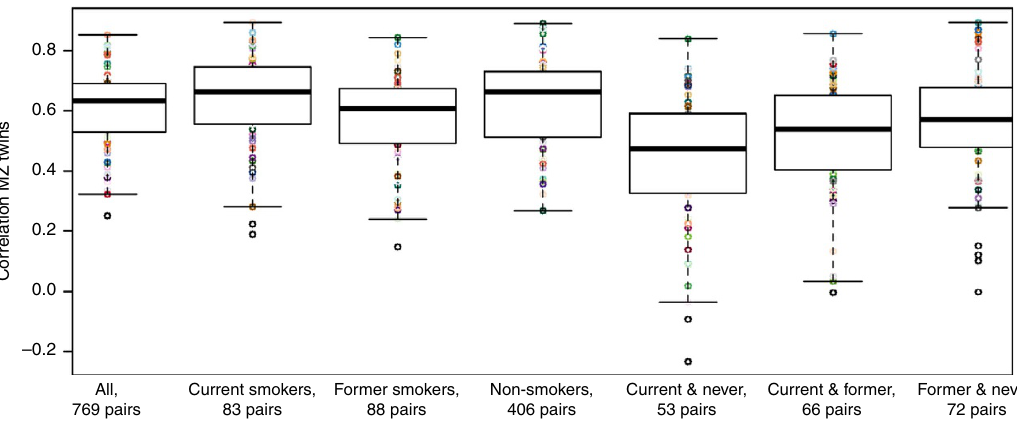
Figure 7 | Boxplots of the correlations between DNA methylation levels in smoking-concordant and smoking-discordant MZ twins. Correlations are plotted for DNA methylation level at 65 CpGs that showed significant interaction between age and environmental variance and that were previously found to be associated with smoking 12 . The boxes denote the 25th and 75th percentile (bottom and top of box), and median value (horizontal band inside box). The whiskers indicate the values observed within up to 1.5 times the interquartile range above and below the